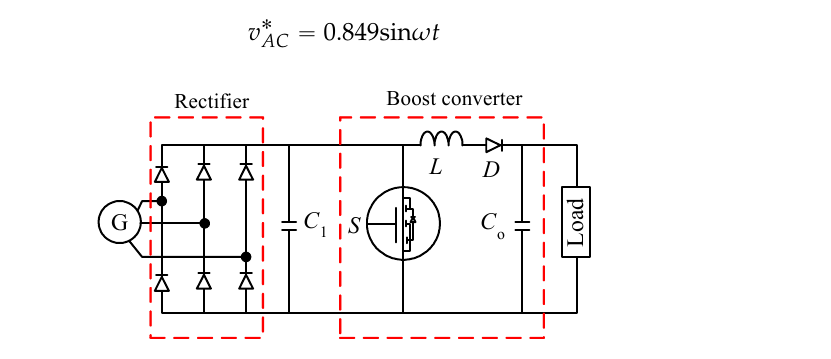
1 : Linking capacitor; C 0 :